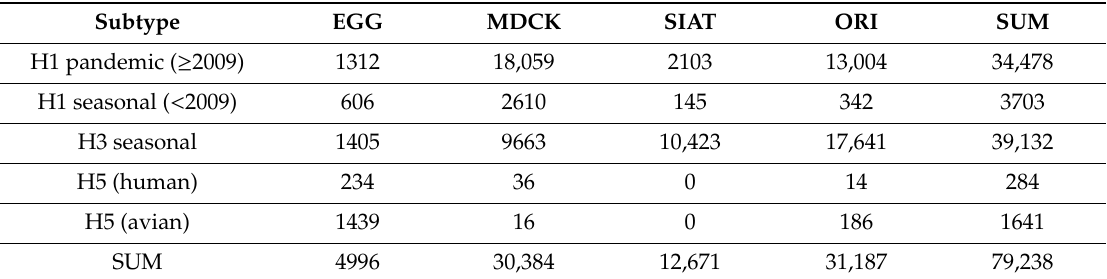
Table 1. Summary of HA sequences used in this study classified into four passage